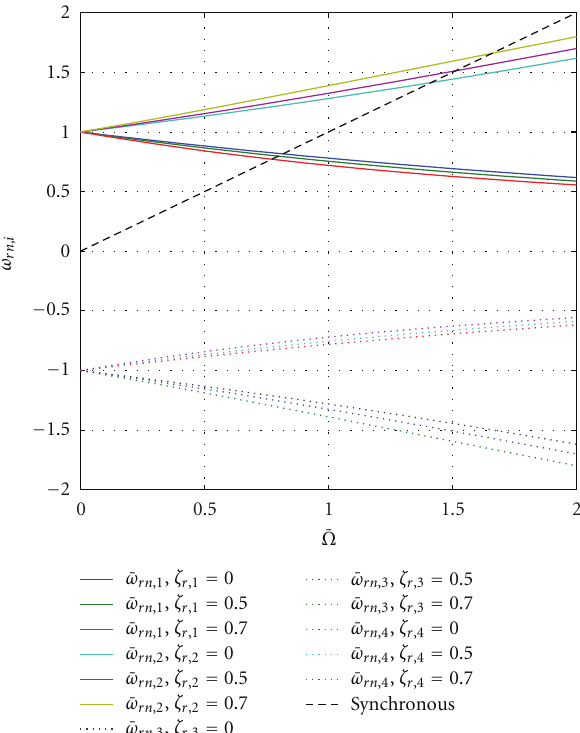
Figure 3: Undamped natural frequencies, various damping ratios, P = 0 .